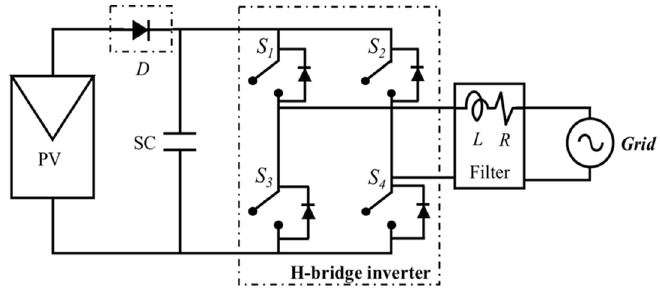
Figure 1. Ideal schematic representation of the analyzed renewable power system.